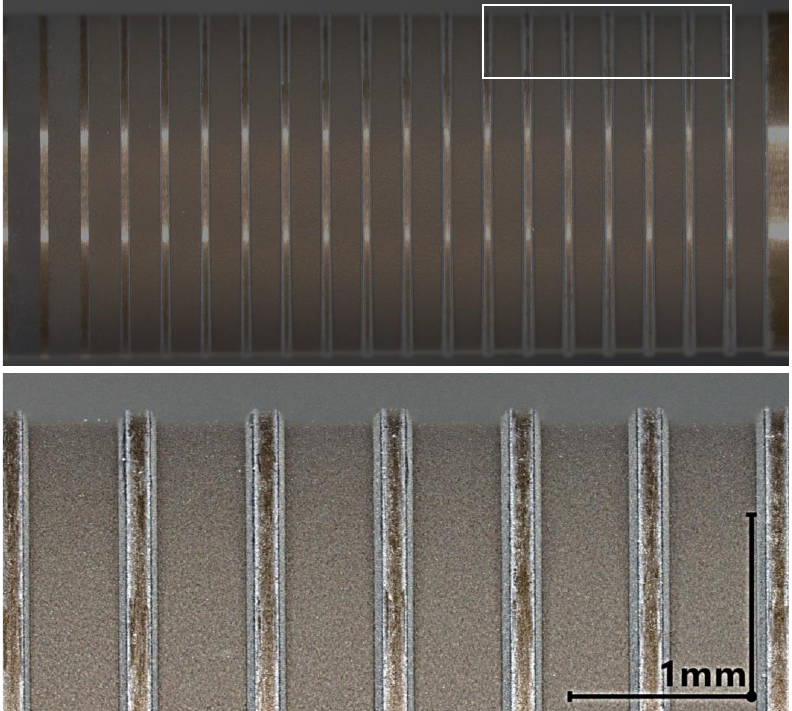
Figure 6. Top : Cylindrical SiAlON sample LST 320 with a blank diameter of D = 6 mm after the laser ablation experiment at θ = 75°. Material removal can be detected for the whole range of E p . Bottom : Detailed view of the groves machined with a pulse energy from E p = 15 µ J to E p = 20 µ